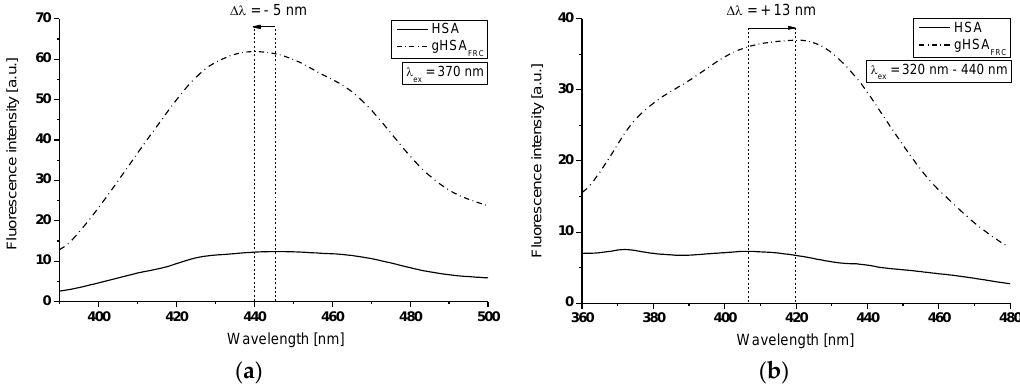
Figure 3. AGEs emission and synchronous fluorescence spectra of HSA and gHSA FRC excited at ( a ) λ ex = 370 nm and ( b ) λ ex = 320–440 nm (Δλ = 40 nm), respectively; protein concentration equals to 5 × 10 −6 mol∙L −1 ; t = 37 °C.